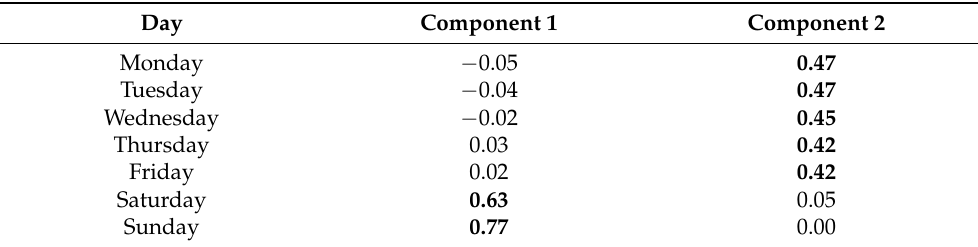
Table 4. Component matrix C for days of the week. (Note: component scores higher than 0.20 in absolute value are in bold).